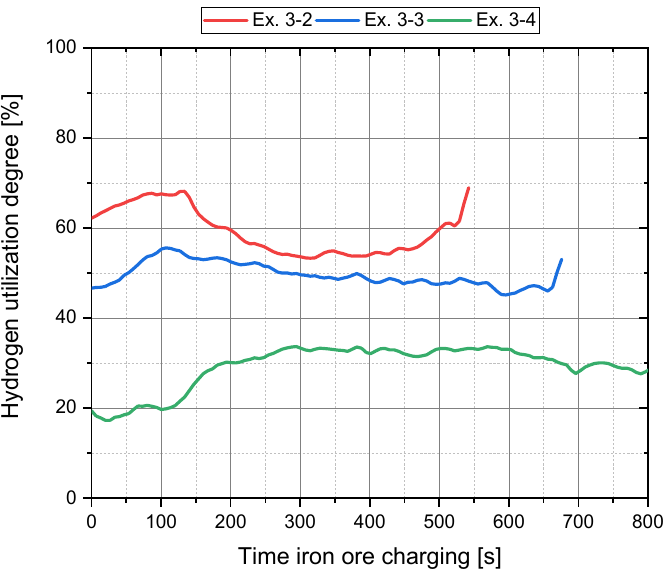
Figure 11. Hydrogen utilization during charging (Phase 4) for Ex. 3–2 to Ex. 3–4.